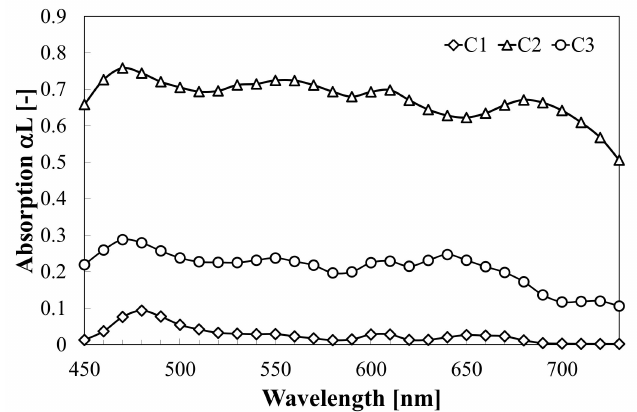
Figure 11. Absorption for 1 mm sample thickness approximately corrected for longer path lengths taking into account single scattering events from grains and pores within an angular range up to the total internal reflection